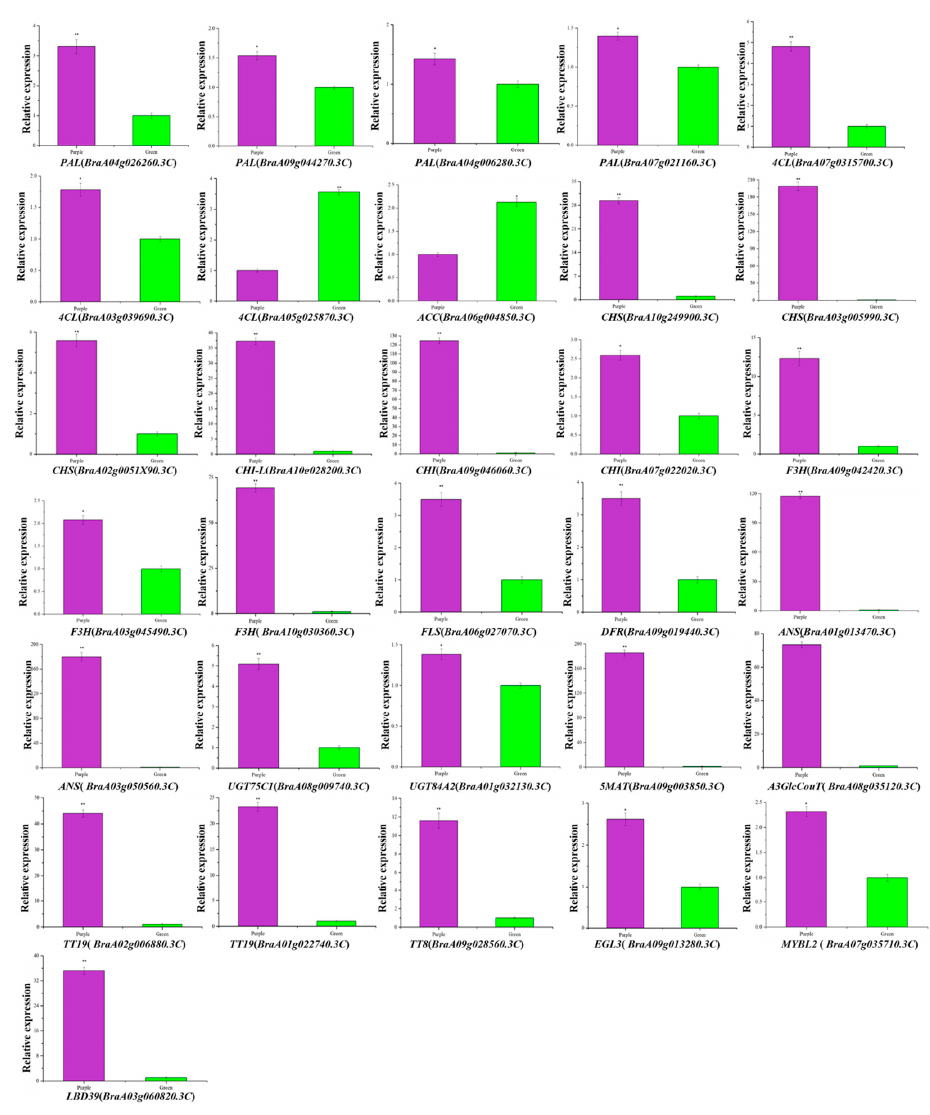
Figure 8. Expression analysis of DEGs associated with anthocyanin biosynthesis between purple non-heading Chinese cabbage and its green mutant. Expression analysis of PAL ( BraA04g026260.3C ,